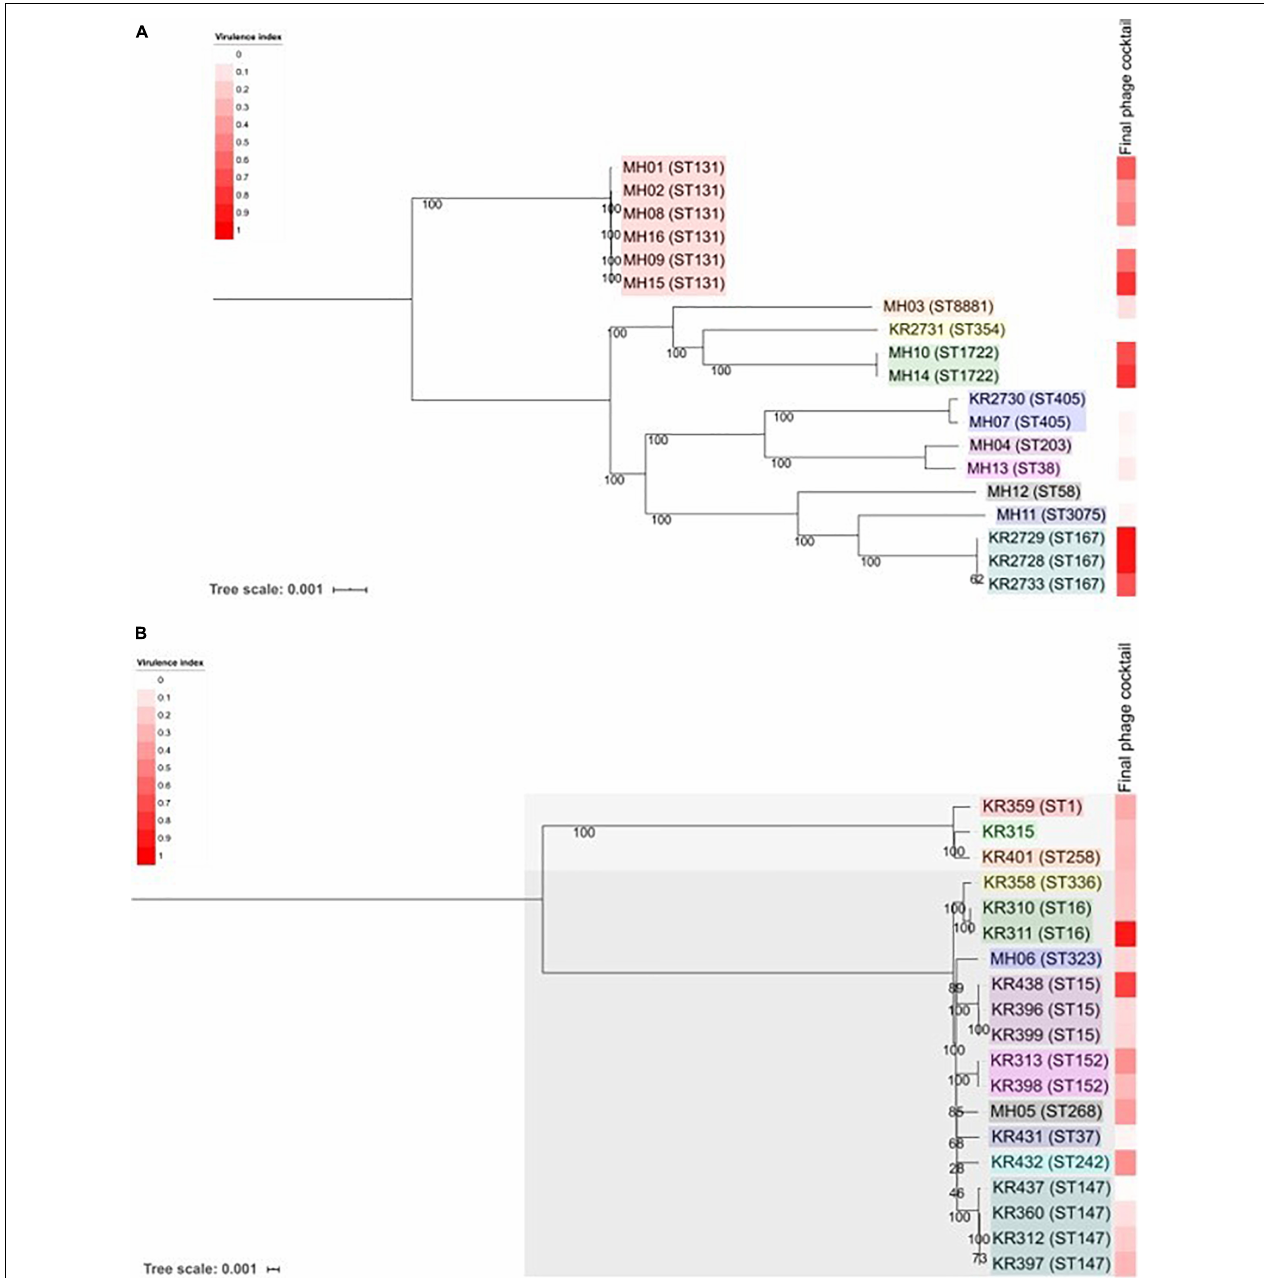
FIGURE 4 | Phylogenetic analysis of the 38 ESBL-producing clinical isolates used in this study. (A) Shows ESBL-producing E. coli and (B) shows ESBL-producing Klebsiella spp. Trees were produced using MEGA7 to assess the core genome SNPs. Core-genome SNP analysis revealed that there were two species of Klebsiella . KR315, KR359 and KR401 are Klebsiella oxytoca and all others are Klebsiella pneumoniae . Each clinical isolate name is followed by its MLST (Achtman—E. coli)—please note KR315 was unable to be assigned. Tree scale noted and bootstrap values are labelled on branches. Coloured boxes within each tree represent groups of sequence types. The heat map on each tree represents the virulence index score assigned to the final phage cocktail for each